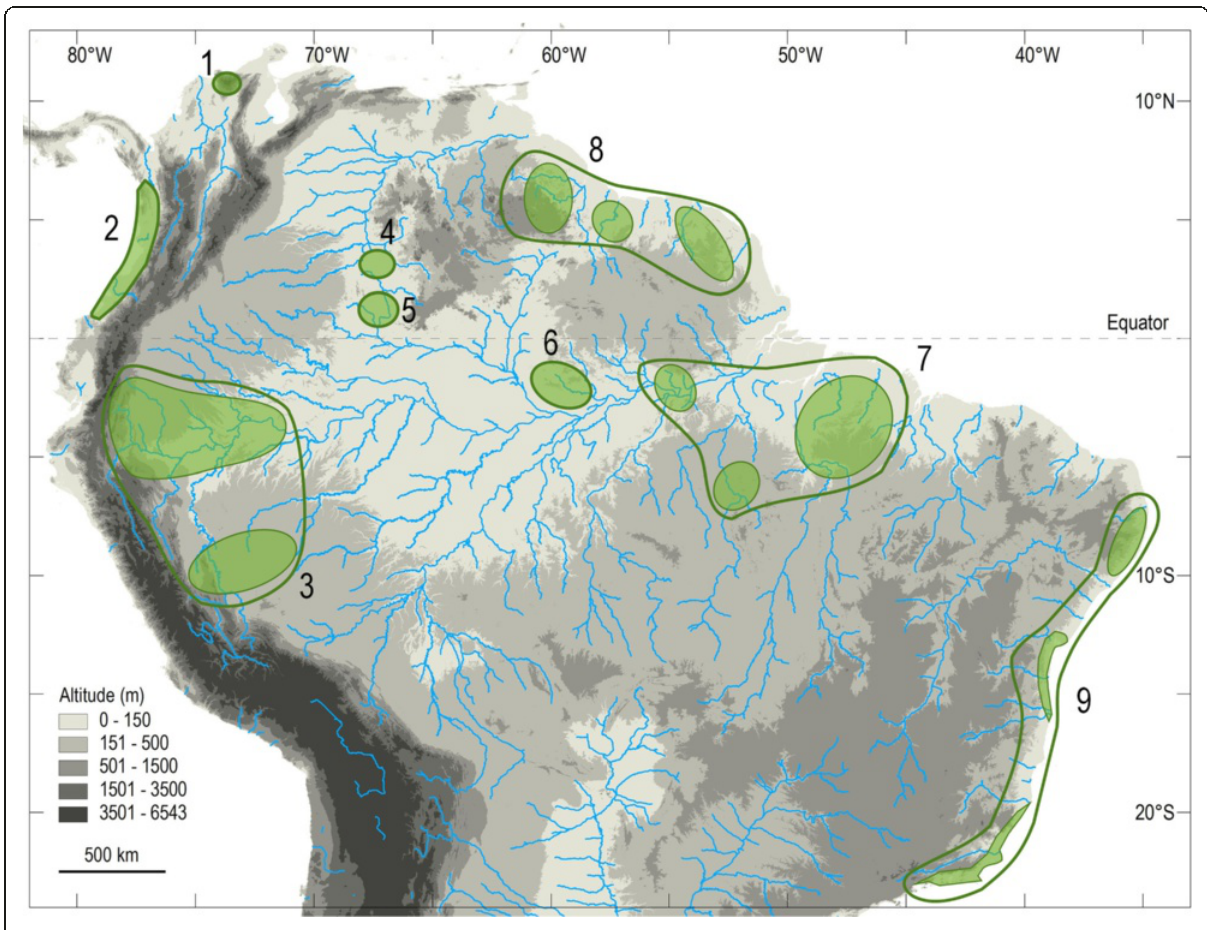
Fig. 27 Major centers of scorpion endemism in tropical South America. For further details, refer to Lourenço